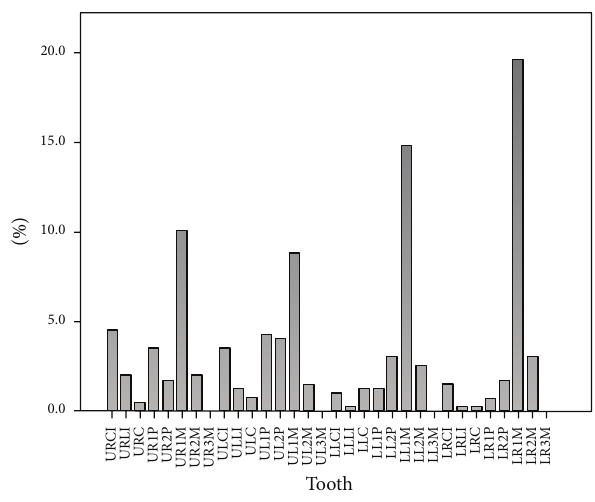
Figure 7: Percentage of overfill in individual teeth.